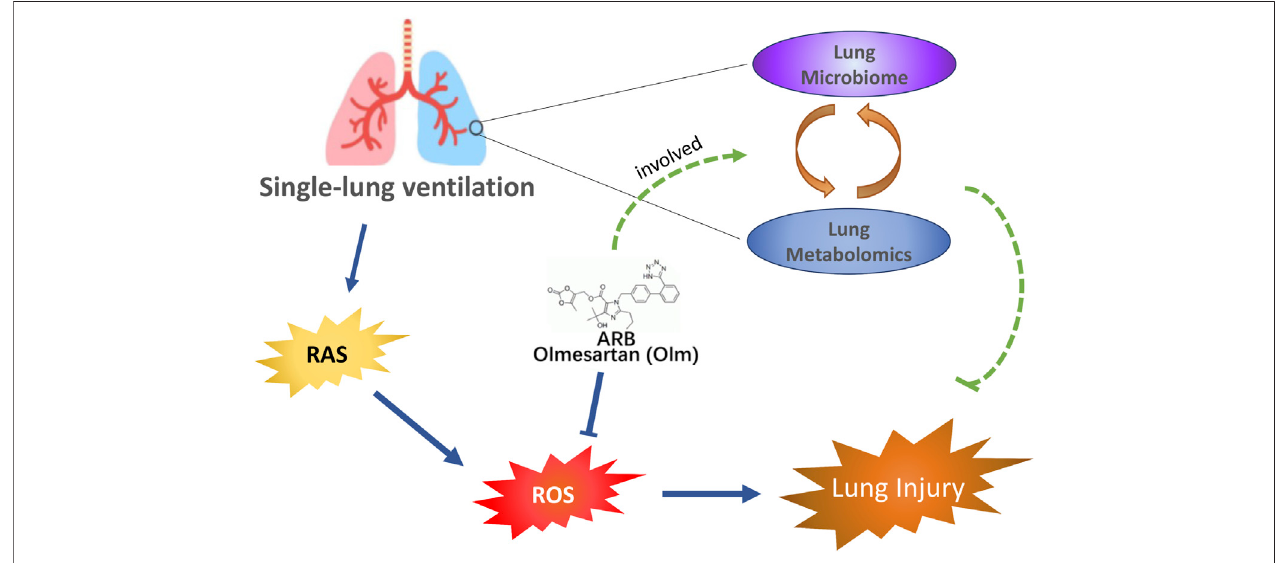
FIGURE 7 | Olm plays a positive role in the prevention of SLV-induced lung injury. In addition to its traditional blockage of the renin-angiotensin II system, Olm may play a positive role in the prevention of SLV-induced lung injury through the pulmonary microbiota and metabolites. SLV: single-lung ventilation; Olm: olmesartan.